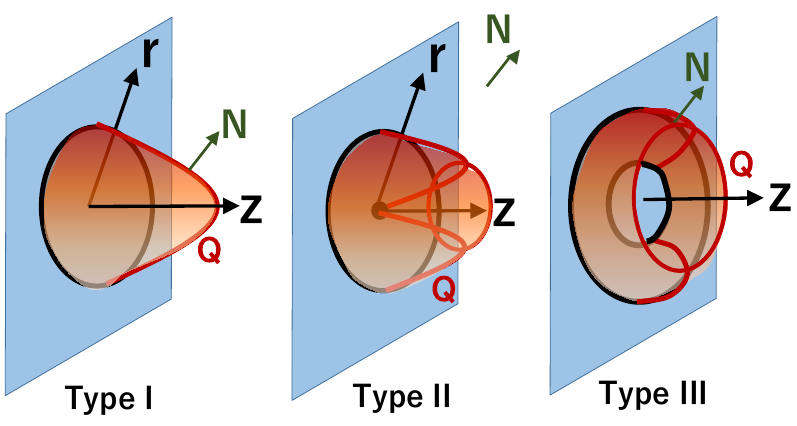
Figure 10 . The setups of AdS 3 / BCFT 2 with a round EOW brane: classified into Type I (left), II (middle) and III